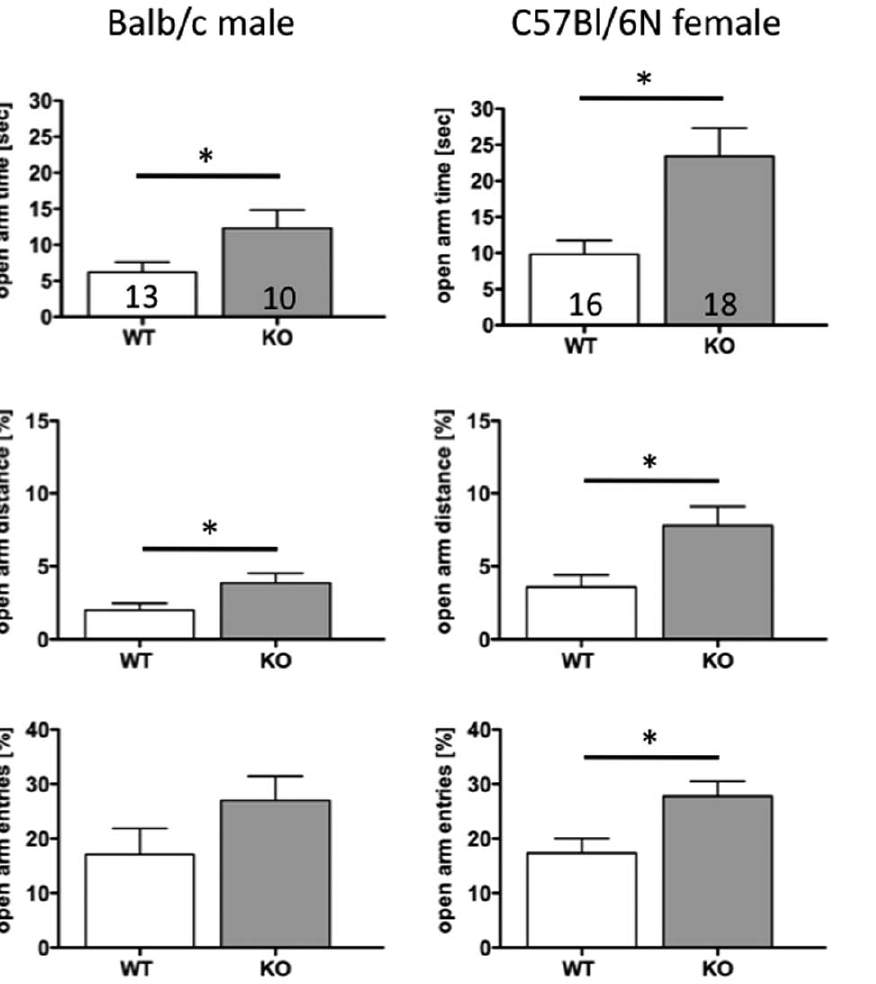
Figure 2. Ambulation on the elevated plus maze by Pdyn KO (shaded bars) and WT (white bars) mice was measured for 5 min. Time spent (upper row), distance travelled (mid row) and percentage of entries (lower row) onto the open arms are given for male balb/c (left column) and female C57Bl/6N (right column) mice. Data represent mean 6 SD of the number of animals indicated in the bars. Student’s t test was used to compare the two genotypes. * … p , 0.05.